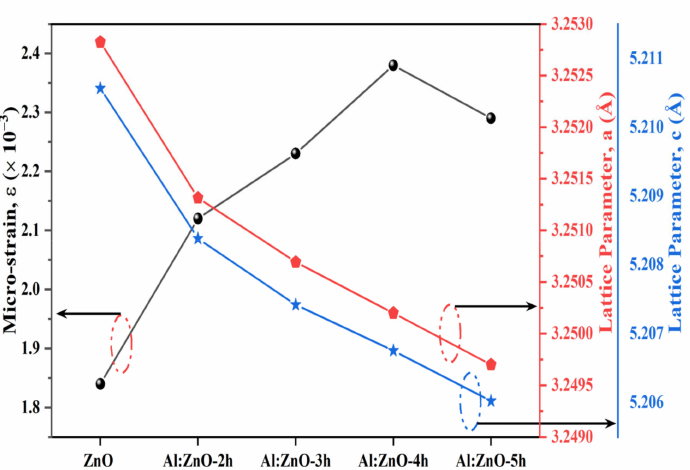
Figure 4. Correlation of micro-strain and lattice parameter of a and c for pristine ZnO and Al:ZnO